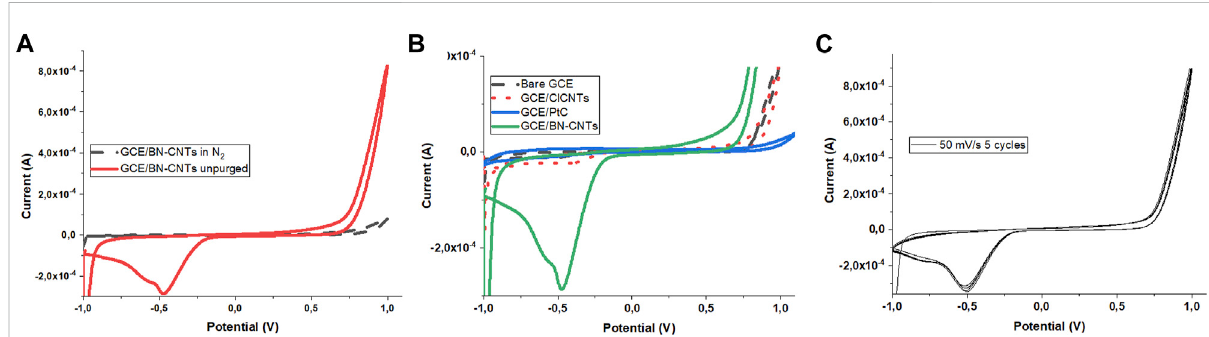
FIGURE 7 Cyclic voltammograms at a scan rate of 50 mV/s of (A) GCE/BN-CNTs showing the effect of N 2 on the ORR peak; (B) bare GCE, GCE/ClCNTs, GCE/PtC, and GCE/BN-CNTs; and (C) fi ve repeated cycles over GCE/BN-CNTs, all produced in 0.1 M